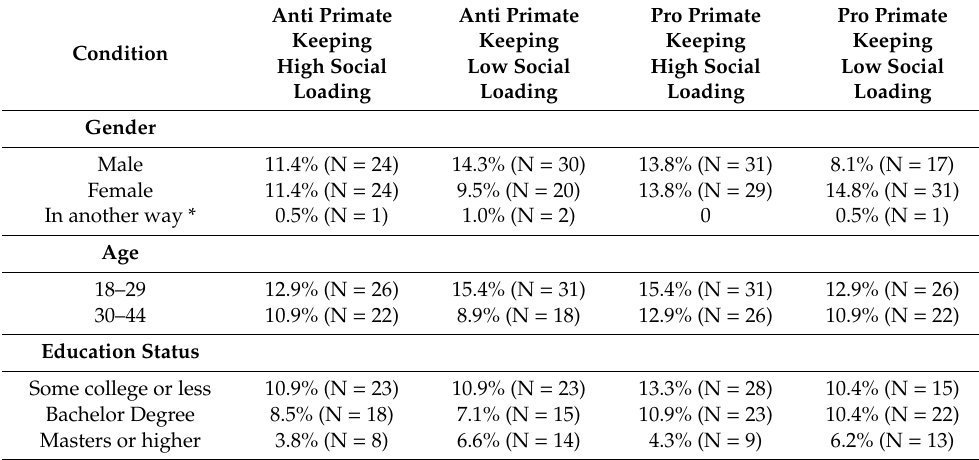
Table 1. Respondent demographics across condition, N =